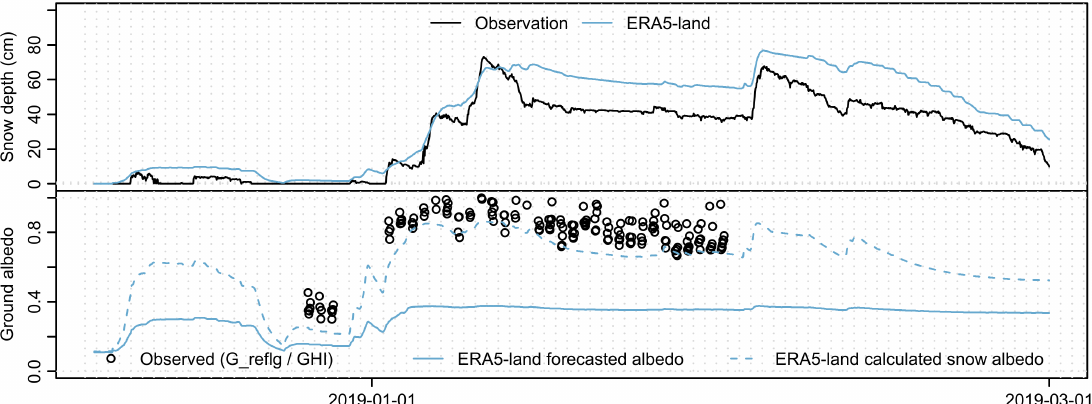
Figure 13. Observed snow depth and ground reflectance (calculated from ground reflected short wave radation) at the Holzkirchen site compared to the ERA5 reanalysis forecasted albedo for the period 7 December 2018 to 28 February 2019. The dashed blue line shows the calculated snow albedo of Table 2.